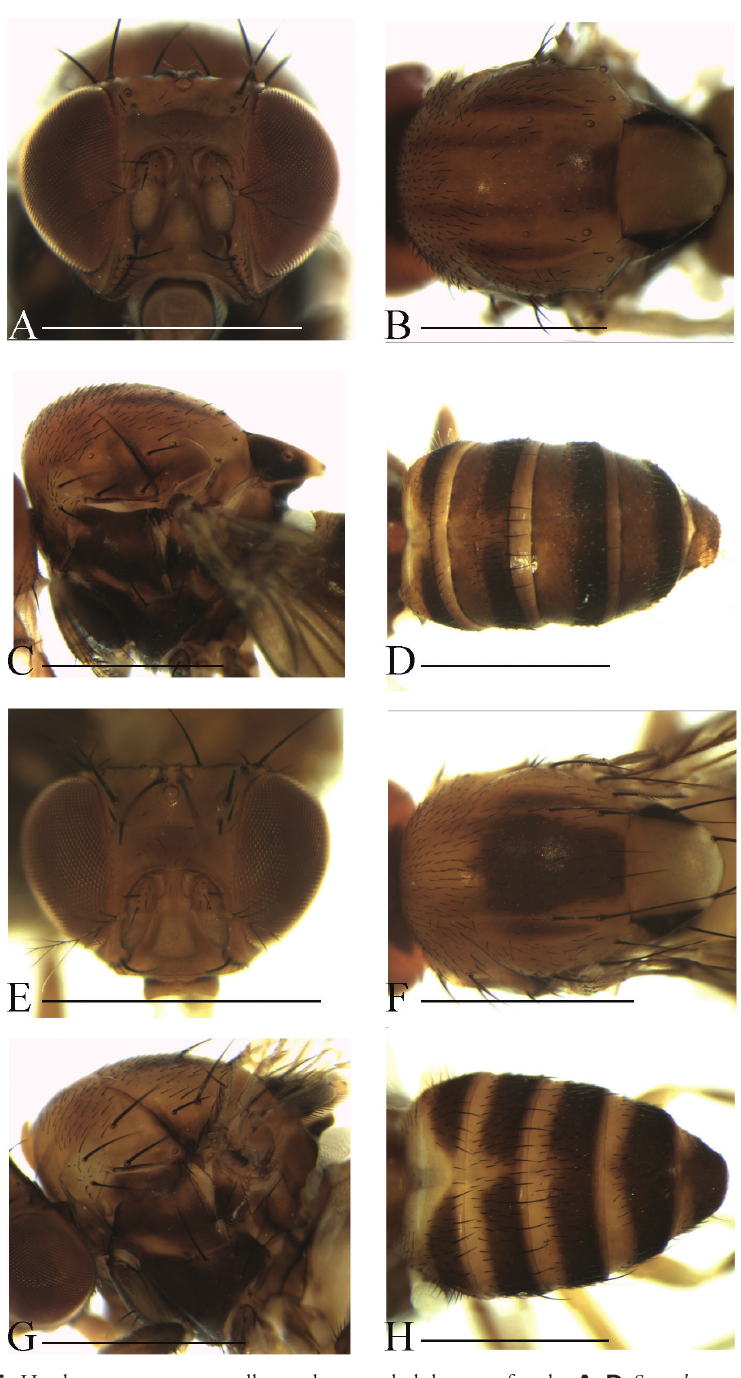
Figure 5. Head, mesonotum, scutellum, pleura and abdomen of male. A–D S. melanogaster sp. n. E–H S . nigricostata sp. n. Scale bars 1